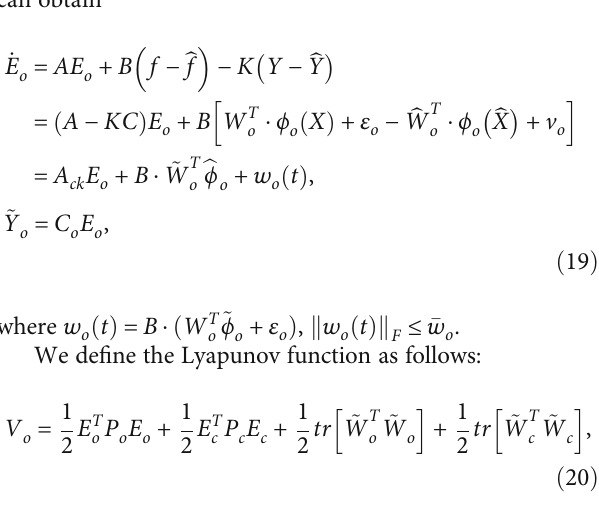
Figure 5: The fl ow chart of system